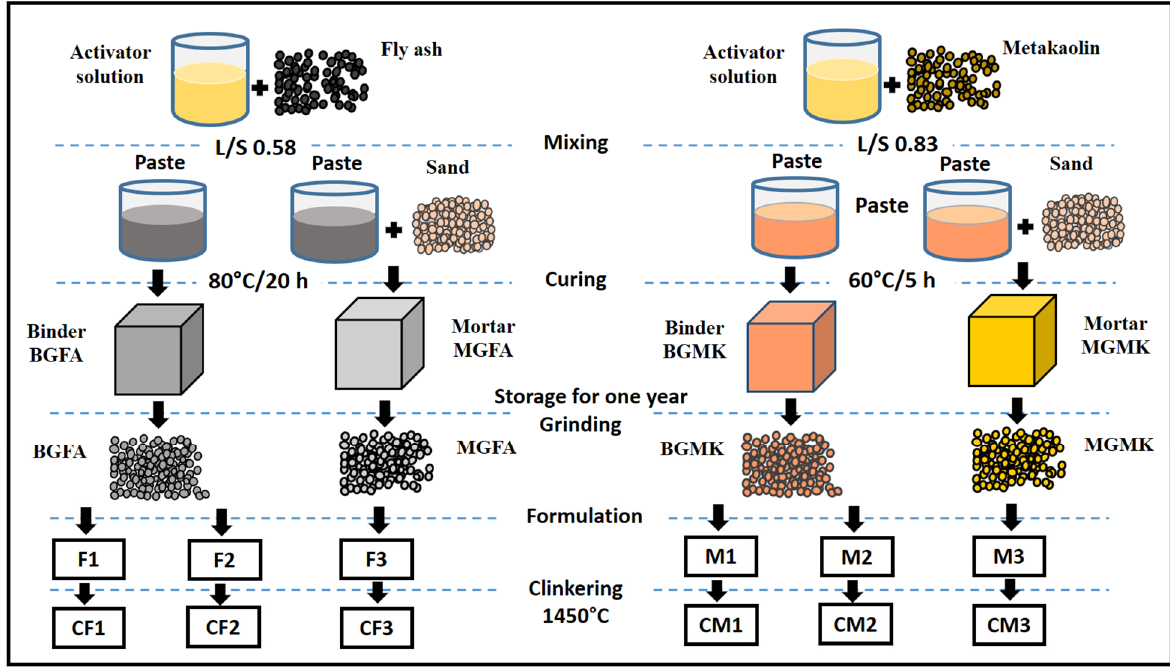
Figure 4. Flowchart representing the procedure for the preparation of cement clinker from geopolymer-basedmaterials.